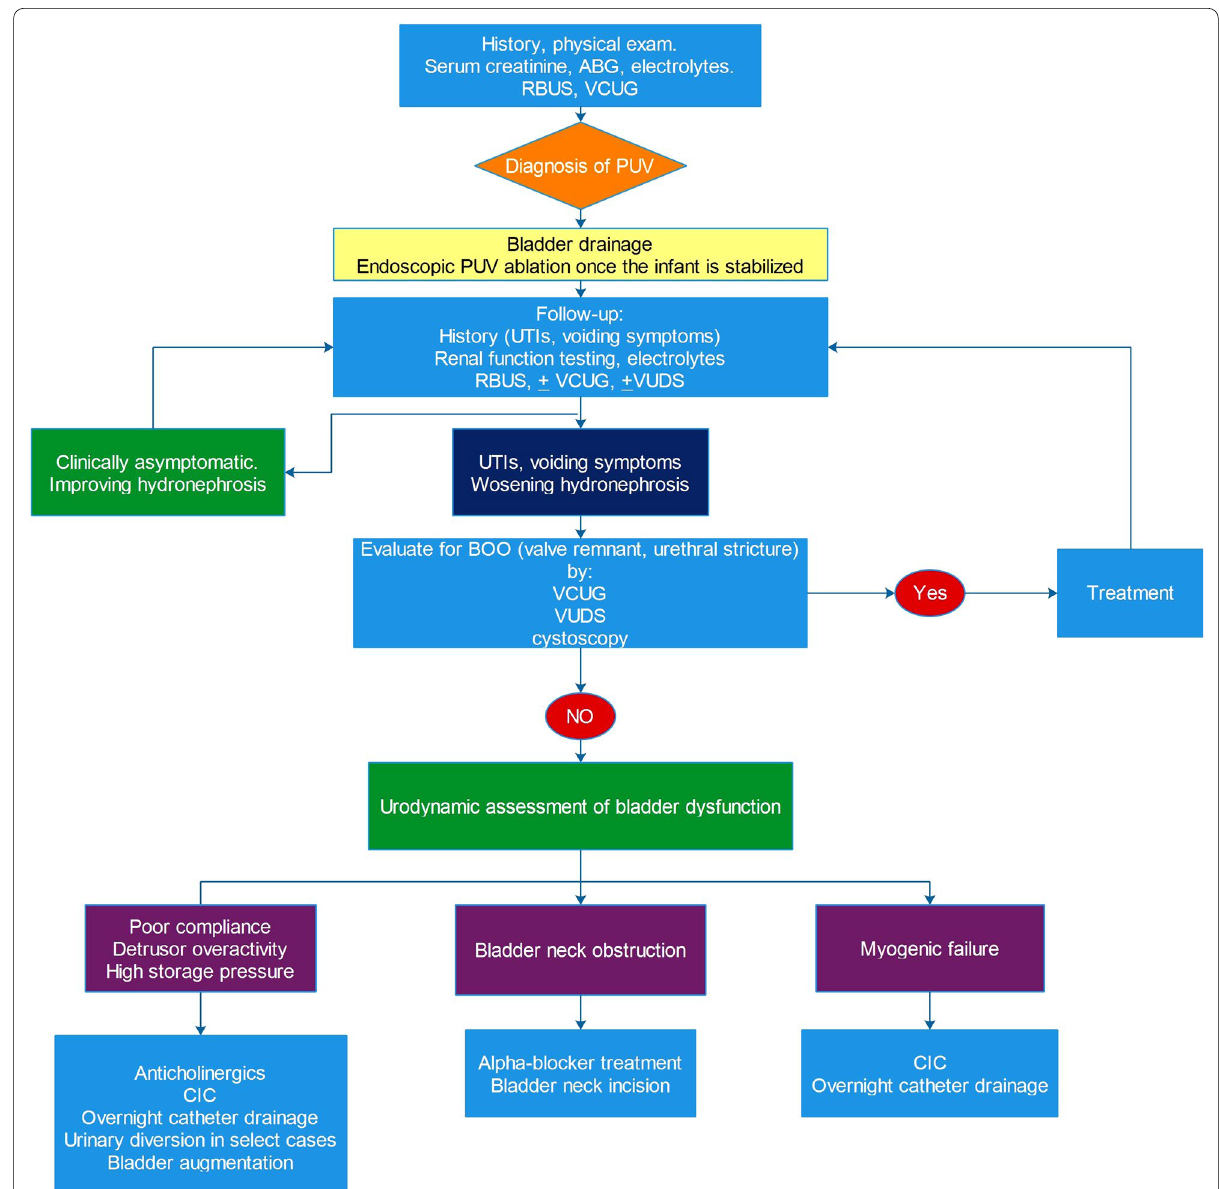
Fig. 5 Summary of the postnatal management of PUV. ABG: arterial blood gases, BOO: bladder outlet obstruction, CIC: clean intermittent catheterization, PUV: posterior urethral valve, RBUS: renal bladder ultrasound, UTI: urinary tract infection, VCUG: voiding cystourethrogram, VUDS: